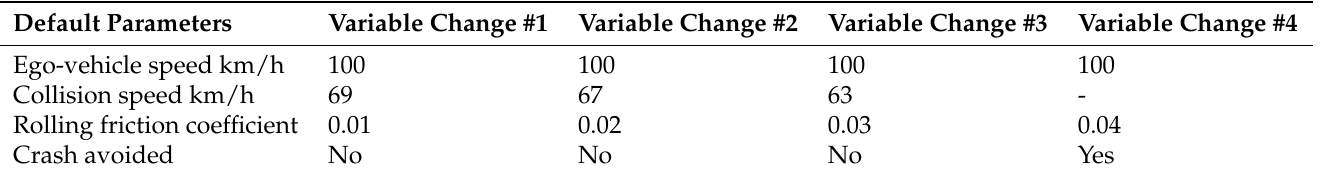
Table 2. Comparison of the effect of rolling friction coefficient.